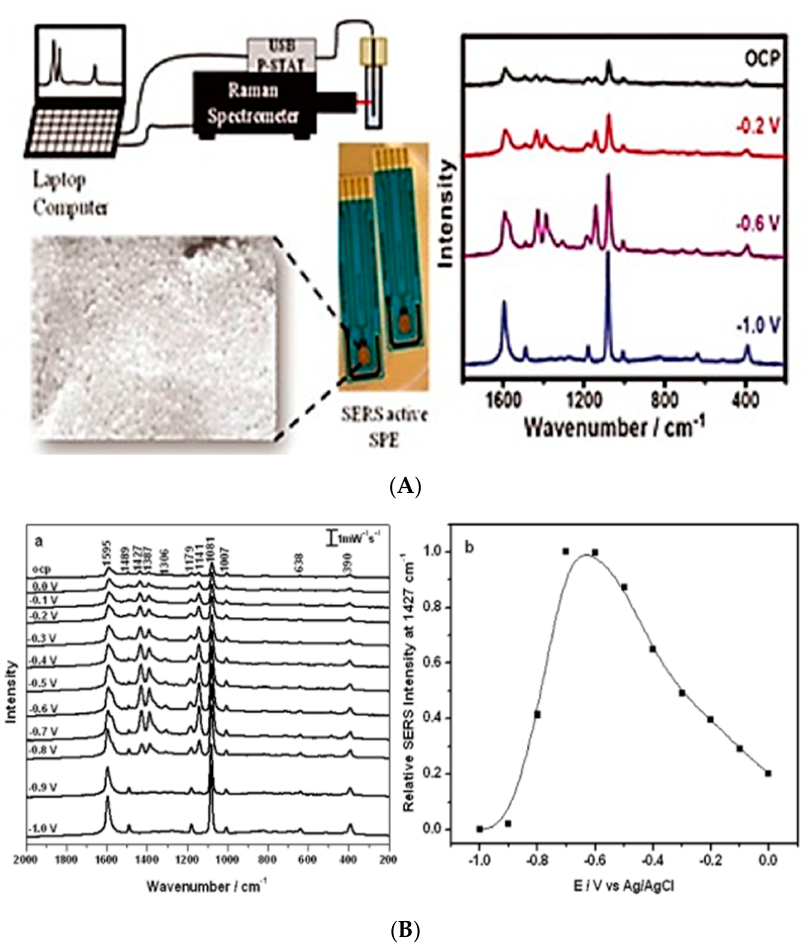
Figure 5. ( A ): Scheme of the miniaturized equipment with a SEM micrograph of the electrode surface, with a typical Raman spectral profile, as output signal. ( B ) Shows on ( a ) a typical electrochemical Surface Enhanced Raman Spectroscopy (SERS) profile for a para ‐ aminothiophenol modified electrode; ( b ) a typical SERS profile (for a specific analyte, such as p,p ′‐ dimercaptoazobenzene_DMAB) depending on its redox potential. Reproduced and reprinted with permission from [14].